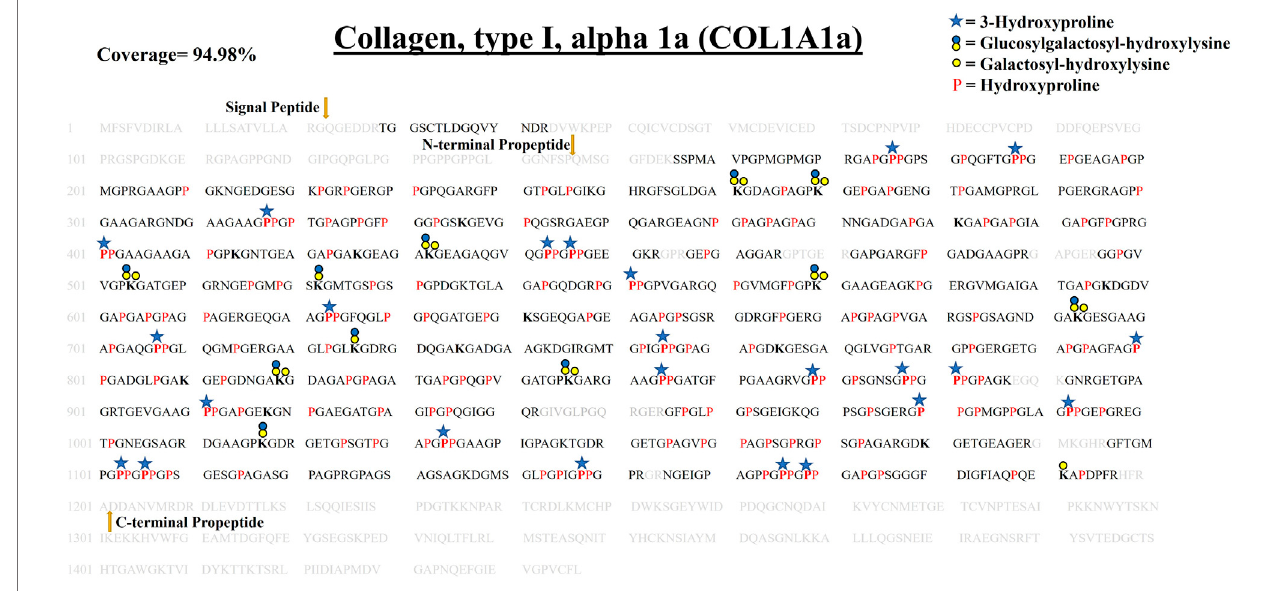
FIGURE 3 | Comprehensive map of proline/lysine hydroxylation sites and lysine O-glycosylation sites in COL1A1a of WT zebra fi sh heart ECM. Identi fi ed peptide sequence in the proteomic analysis is shown in black color, sequence not identi fi ed in this analysis are shown in grey color. A total of 94.98% sequence coverage of COL1A1a is detected (considering the matured form of COL1A1The signalgnal peptide is 22 amino acids (1 – 22) long. Sequence alignment matching with human COL1A1 revealed the propeptide cleavage sites. Dark yellow arrows show N terminal (23 – 146) and C-Term (1,202 – 1,447) propeptide cleavage sites. As shown in the top right corner, red bold “ P ” with a blue star represents 3-hydroxyproline on the Xaa position followed by 4-hydroxyproline the on Yaa position in the Gly-Xaa-Yaa motif. 4-hydroxyproline on Yaa position is represented with red color “ P ” . Hydroxyproline on unusual Xaa position with (Ala, Val, Met, Ile, Ser, Glu, Arg, and Asp) on Yaa position are also identi fi ed but cannot label either 3-hydroxyproline or 4-hydroxyproline. Hydroxylysine sites are presented by bold “ K ” . Lysine sites highlighted with a yellow circle represents galactosyl-hydroxylysine sites and yellow plus blue coloued circles represent glucosylgalactosyl- hydroxylysine sites. The presence of glucosylgalactosyl-hydroxylysine, galactosyl-hydroxylysine, and hydroxylysine on the same site shows lysine microheterogeneity. A summary of these site-speci fi c PTMs of COL1A1a is presented in Table 1 , and all the PSMs for O-glycosylated lysine and 3-hydroxyproline sites are provided in Supplementary Figure S2.1-S2.21